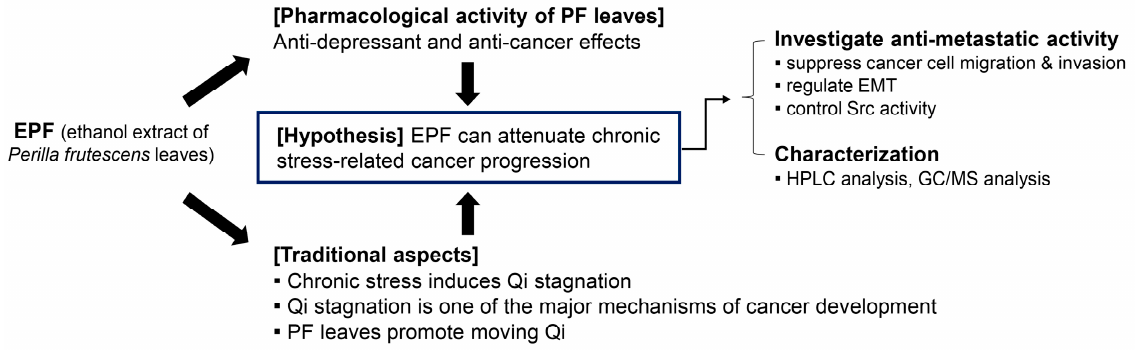
Figure 1. The hypothesis and methodology of this study.